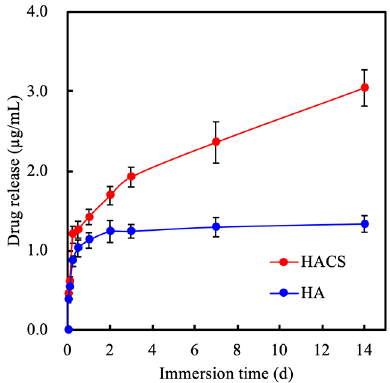
Figure 4. Vascular endothelial growth factor (VEGF) release from HA and HACS scaffolds after immersion in the cultured medium at 37 °C for 14 days.